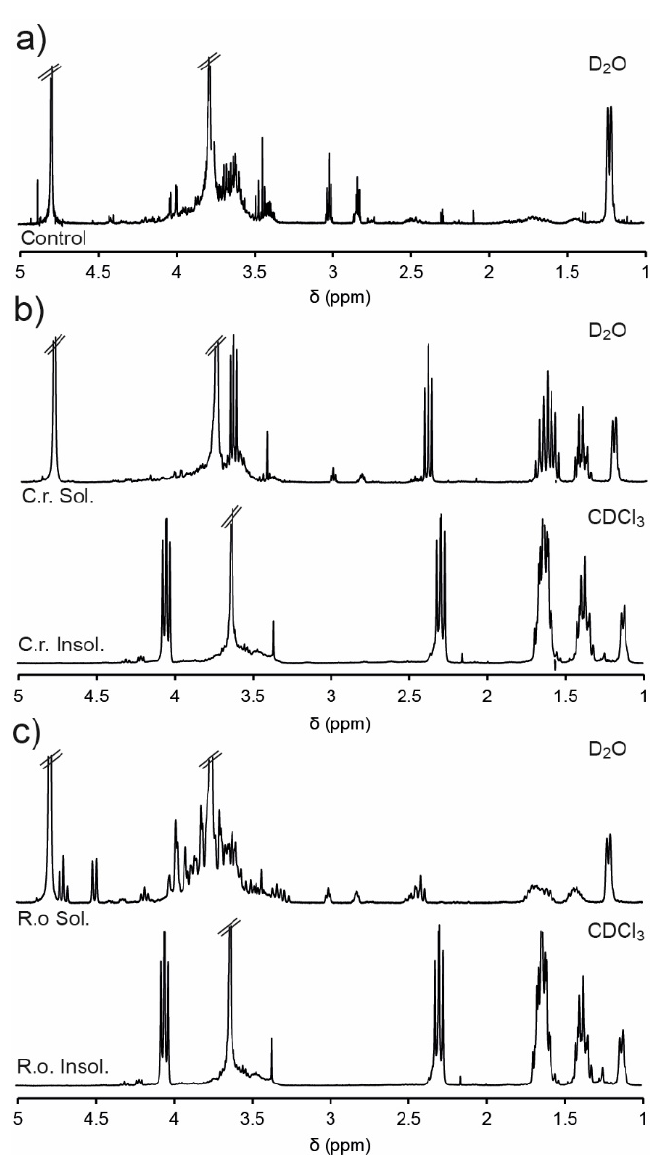
Figure 5. 1 H NMR spectra of ( a ) PEG 1 PPG 2 in D 2 O (5 wt%) before addition of lipase (control), and D 2 O soluble and insoluble (CDCl 3 ) portions following 48 h exposure to ( b ) Candida rugosa and ( c ) Rhizopus oryzae .